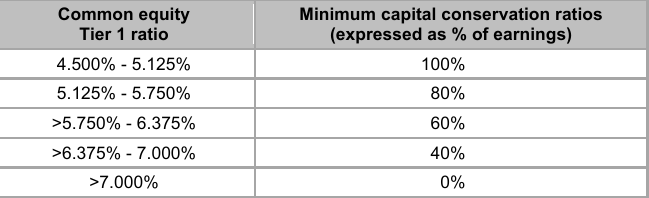
Individual bank minimum capital conservation standards Common equity Tier 1